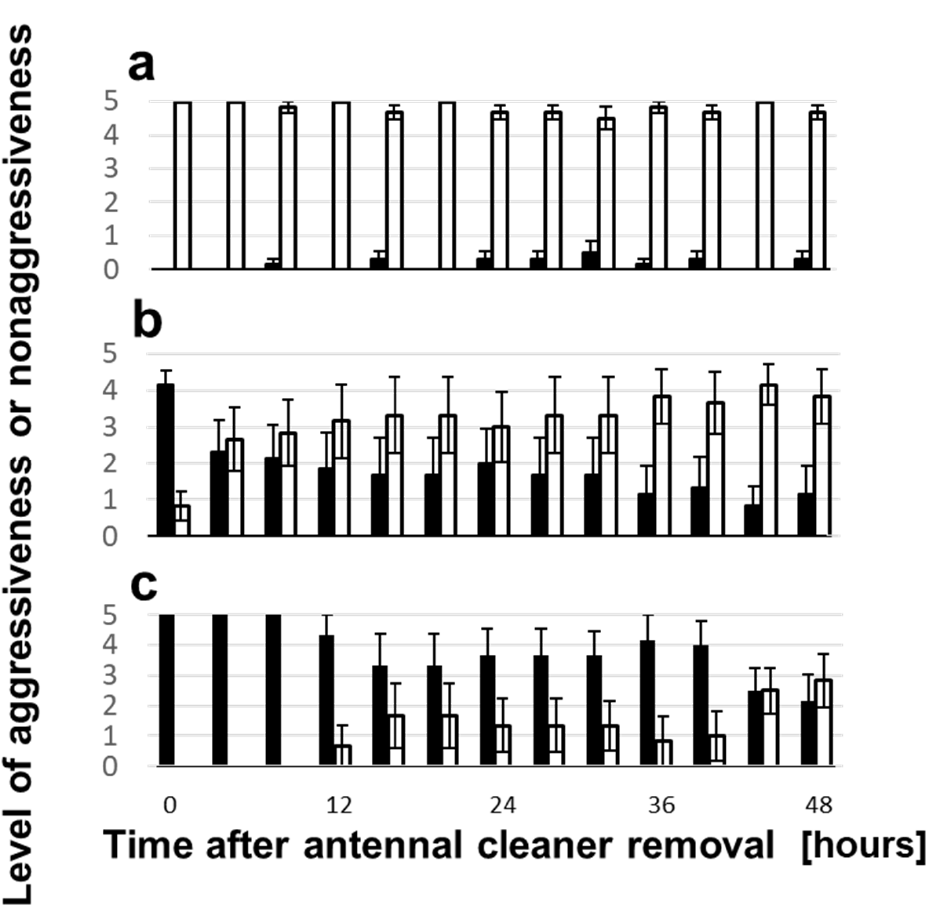
Figure 6. Aggressiveness and nonaggressiveness change in the self-grooming limited ants. Levels of aggressiveness (black columns) or nonaggressiveness (white columns) in the self-grooming limited ants toward conspecific nestmates ( a ), non-nestmates ( b ), and heterospecific workers ( c ) after the antenna cleaner removal operation.